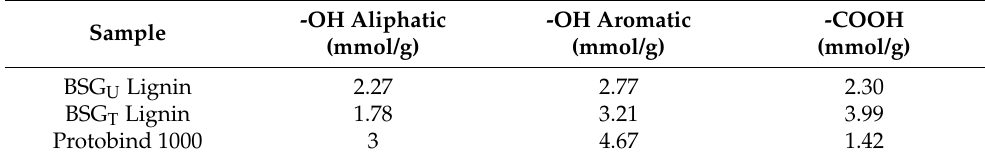
Table 7. Detailed hydroxyl/carboxyl quantification by 31 P NMR (as mmol of functional group per g of dry lignin).